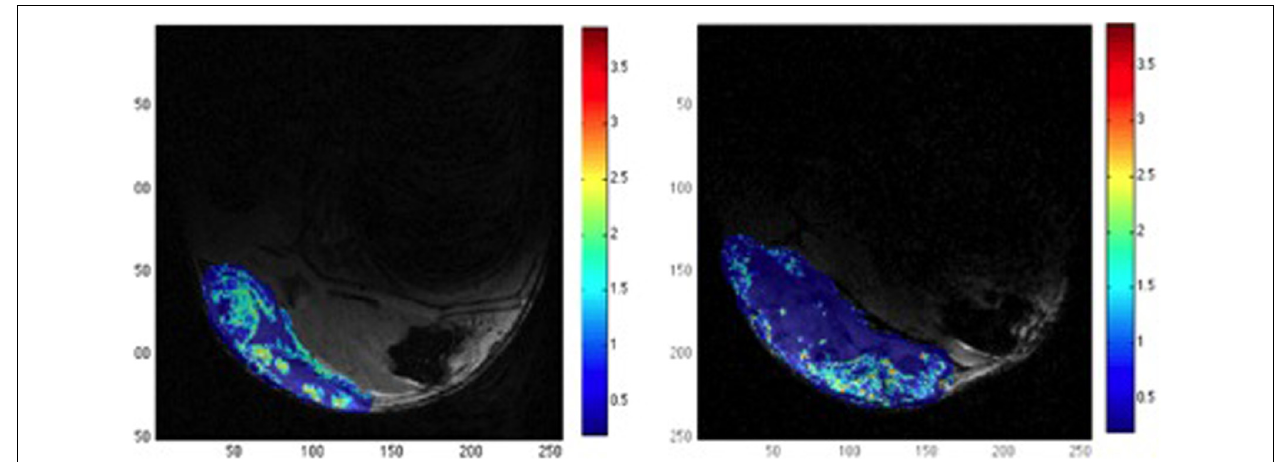
FIGURE 4 | Example of relative tumor blood volume rTBV (color) overlaid on a structural MR image (gray level). The images show the effect of DMOG treatment that affects angiogenesis process ( left ) versus placebo ( right ). DMOG treated tumor shows multiple small regions with